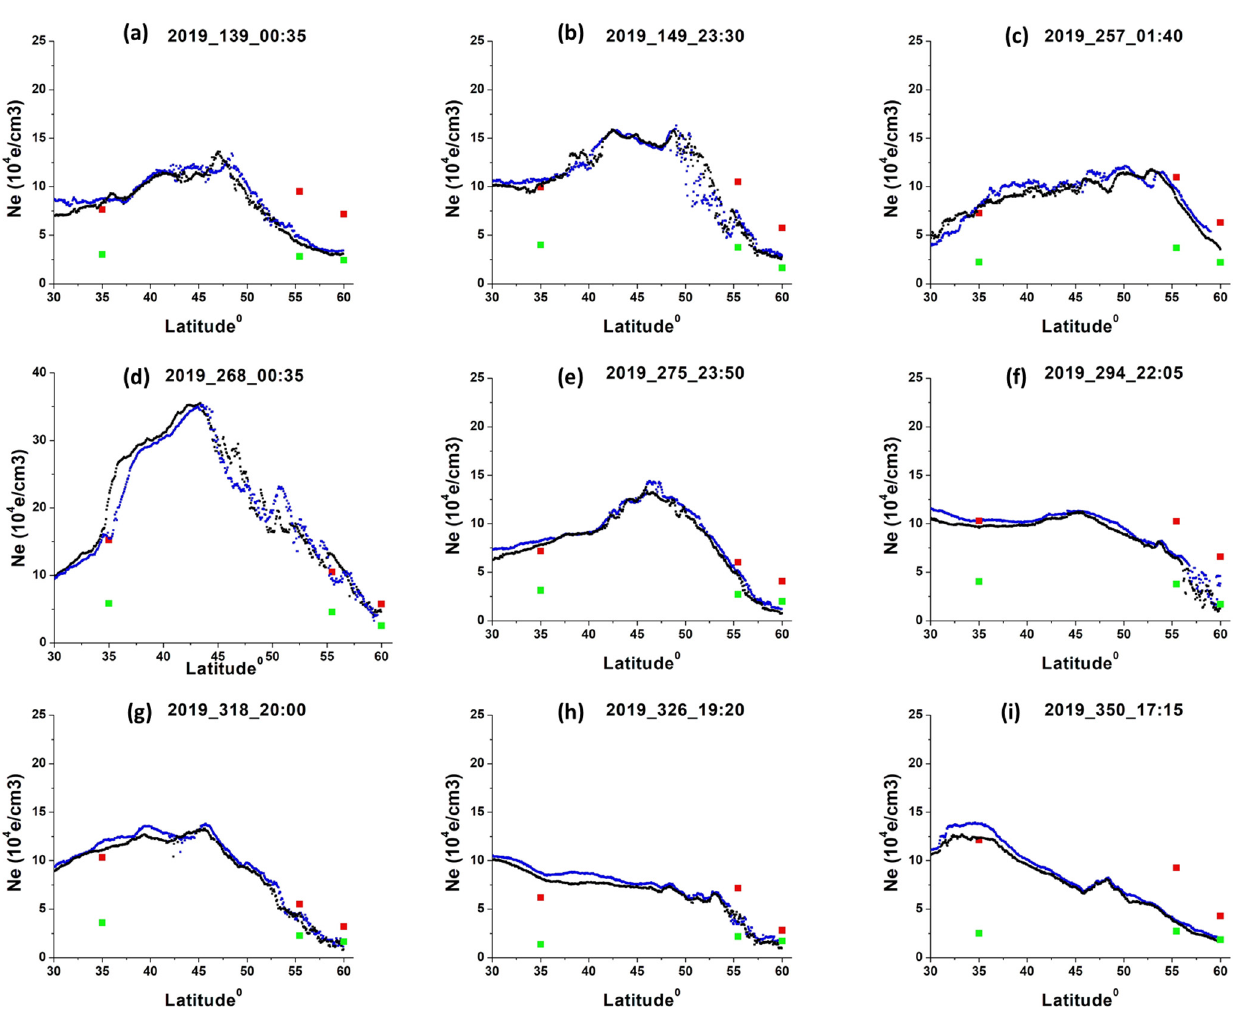
Figure 4. ( a – i ). The graphs show Swarm A (blue) and Swarm C (black) electron density traces with respect to the latitude with IRI-Ne values (green) and Digisonde NmF2 values (red) for the year 2019.